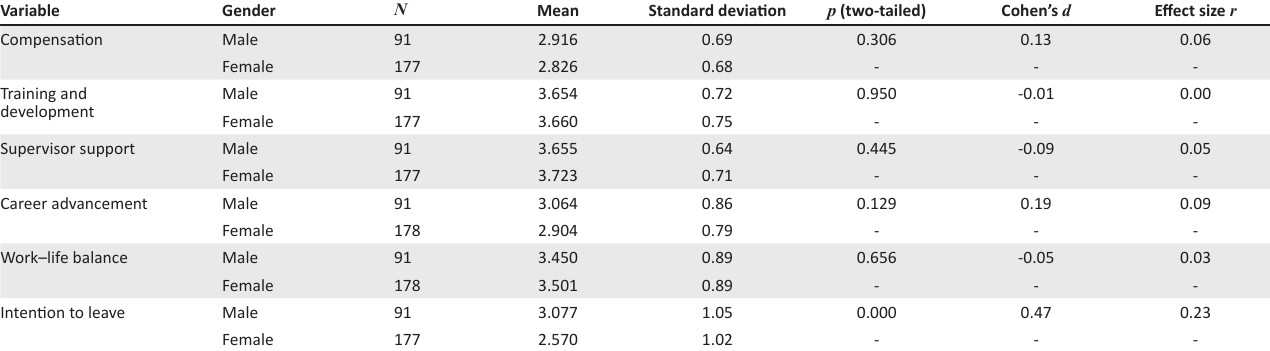
TABLE 5: Independent samples t -test – significant mean differences (gender).